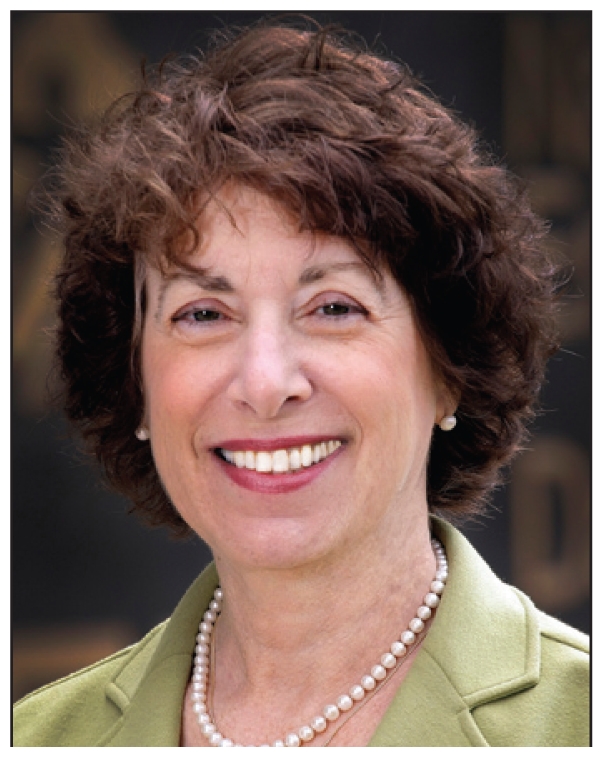
Linda S. Birnbaum